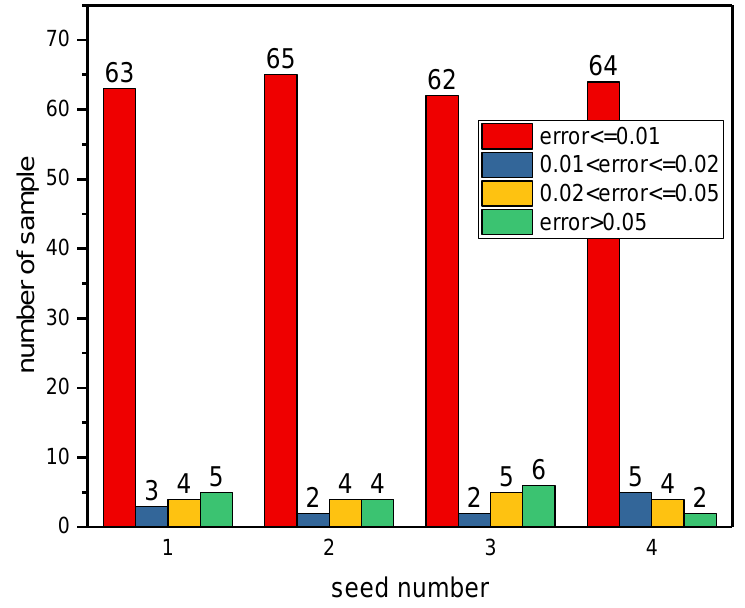
Figure 8. The histogram of errors for the different random seeds.